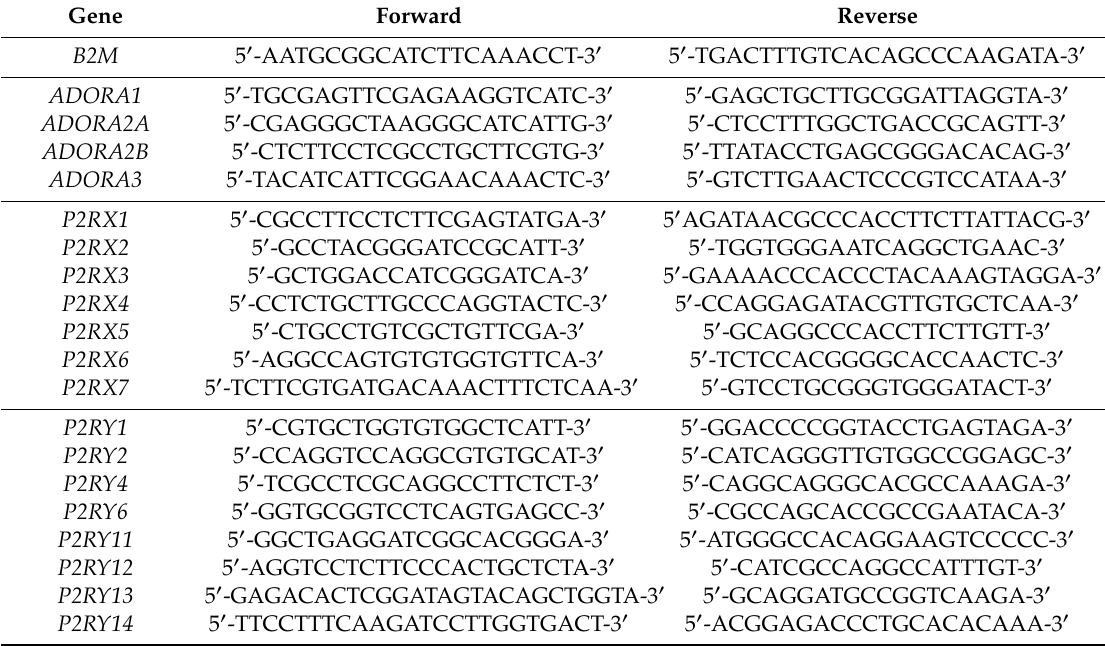
Table 1. Sequences of primers used for quantitative real time PCR